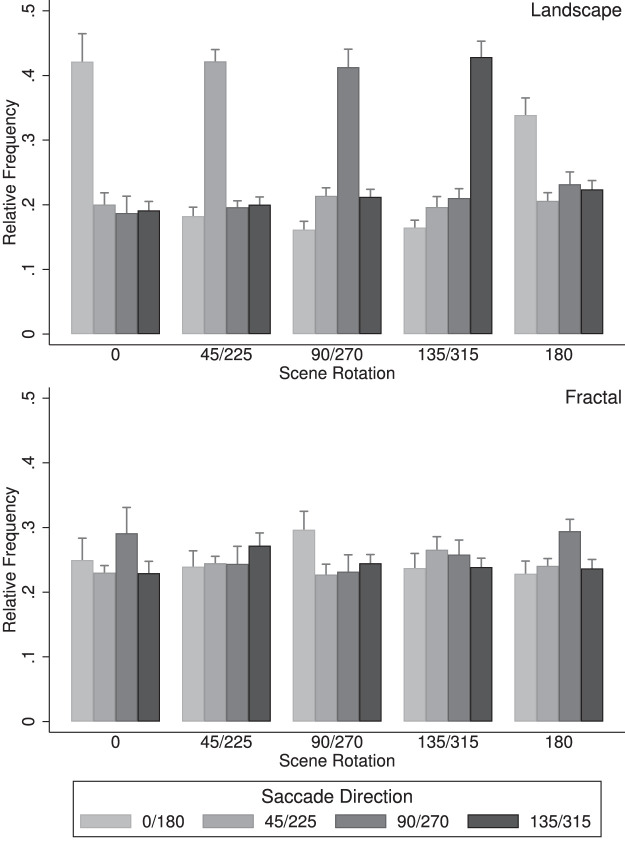
Saccade directions organized into four symmetric axes in world coordinates, for landscape scenes (top) and fractal scenes (bottom). Data show the mean proportions of saccades and standard error bars. Data show the mean proportions and standard errors of head shifts along the four saccade axes (0°/180°, 45°/225°, 90°/270°, and 135°/315°) and the five scene rotation groups (0°, 45°/225°, 90°/270°, 135°/315°, and 180°).